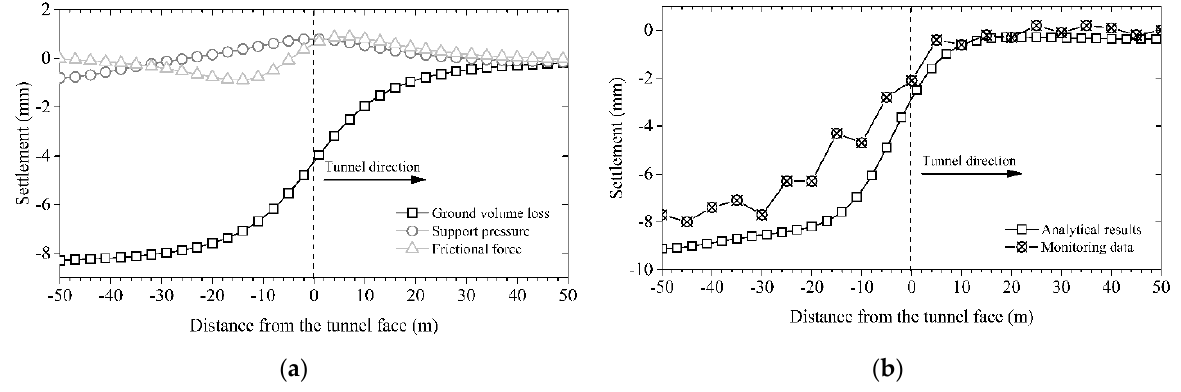
Figure 9. Longitudinal profiles of ground surface deformation during shield tunnelling: ( a ) surface deformation during tunnelling; ( b ) analytical results and monitoring data.